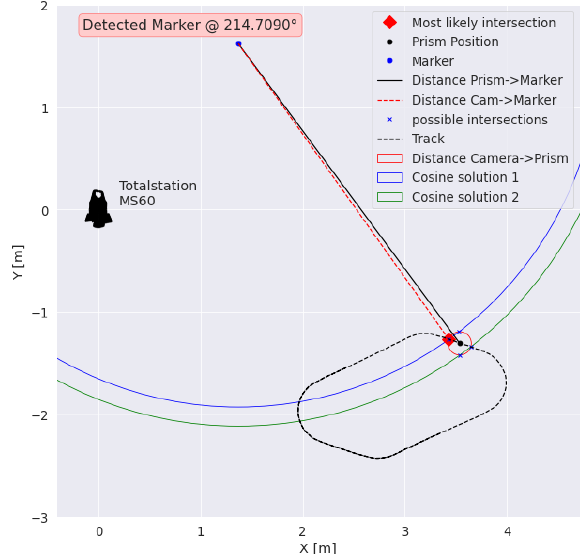
Figure 6. Calculation of possible camera locations: Current prism 3D position (black dot, position via tachymetry), marker 3D position (blue dot), cosine solutions (blue, green) intersected with leverarm camera->prism (red) gives possible camera positions (black crosses). Most likely position (red) in direction of travel. The possible camera locations are calculated with the cosine theorem, which returns four possible locations. The location, which is in the direction calculated from the prism tracking is the most likely position and will be used. 4.3.7 Odom Frame Adjustment: Finally, the orientation